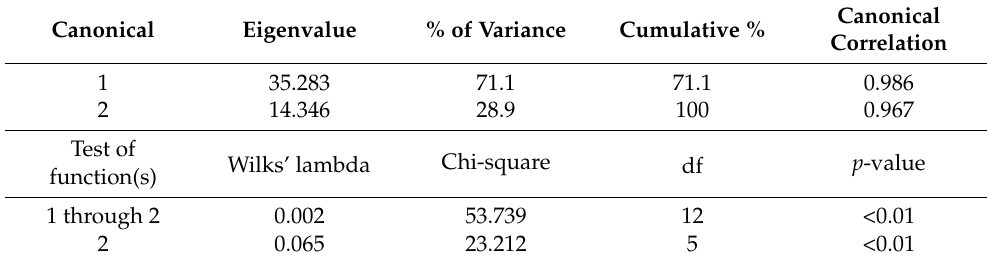
Table 5. Canonical correlation analysis.